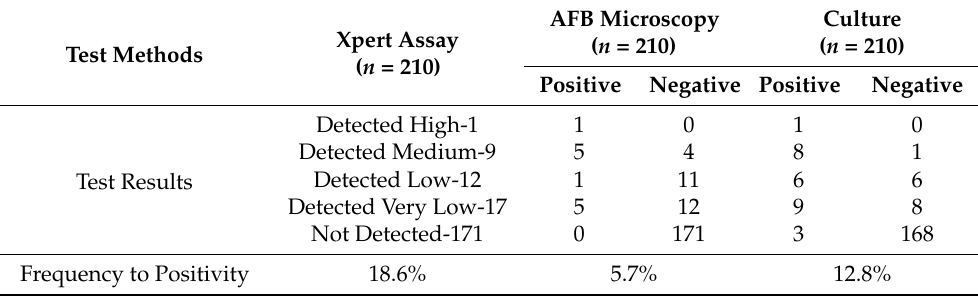
Table 2. Performance of Xpert assay, AFB microscopy, and culture methods for the detection of pulmonary TB from BAL fluid specimens.